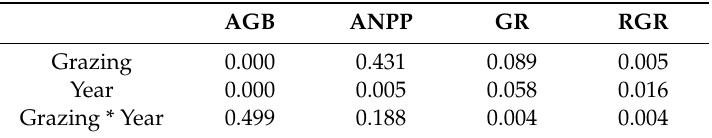
Figure 4. The effect of grazing intensity on aboveground net primary production at the continuous grazing system. a, b, c, means followed by the same small letters are not significantly di ff erent ( p < 0.05). Table 1. Results ( p -values) of two-way ANOVA on the e ff ects of grazing, year, and their interactions on aboveground biomass (AGB), aboveground net primary production (ANPP), growth rate (GR), and relative growth rate (RGR). AGB ANPP RGR